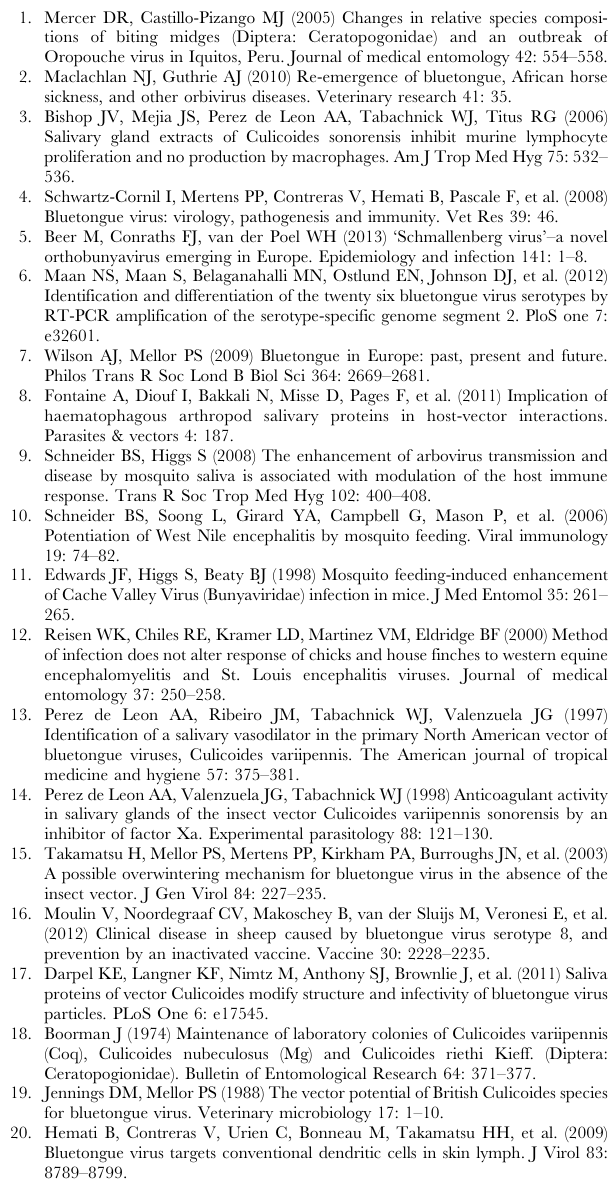
Table S4 Primers used to detect expression of sheep genes in blood cells (qPCR). Primers for the sheep genes were designed by the Primer Express software and provided . 95% amplification